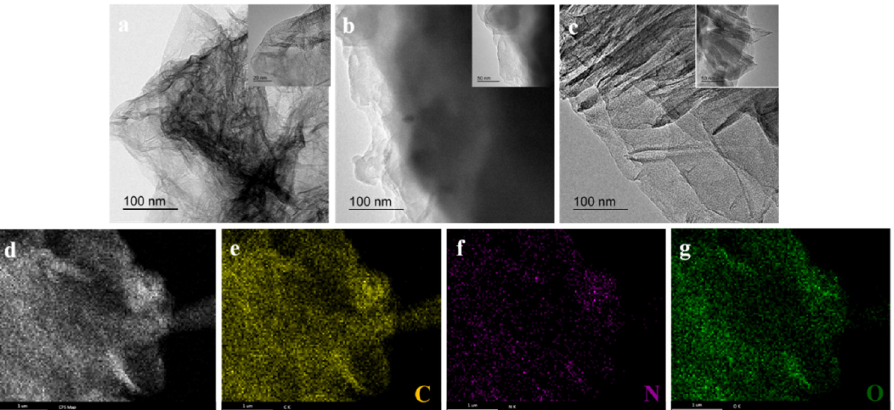
Figure 3. TEM images of G ( a ), COFs ( b ), G/COFs ( c ); the HAADF image of G/COFs ( d ); and the corresponding EDX area mapping ( e – g ). corresponding EDX area mapping ( e – g